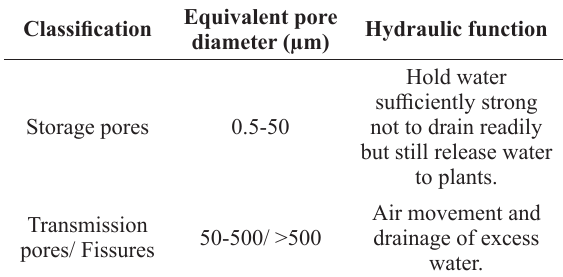
Classification of soil pores according to their hydraulic function (Greenland 1977).